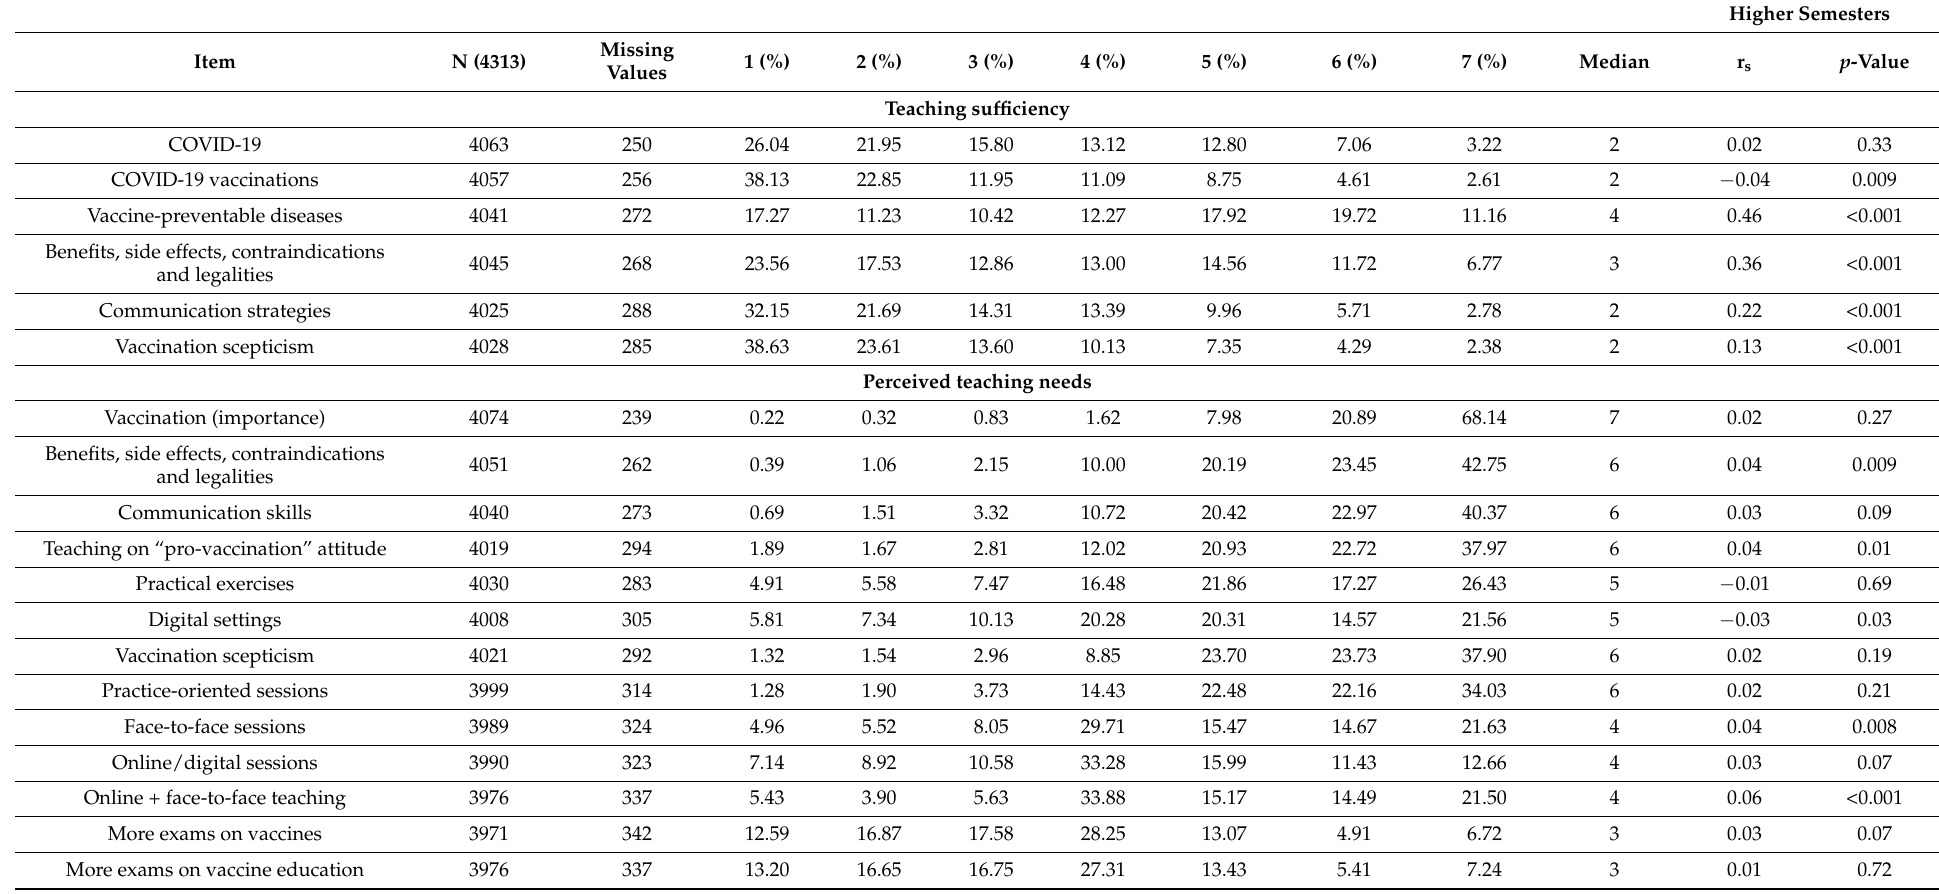
Table 1. Complete case analysis of questions related to teaching status on vaccinations and informing others, shown for all students who answered the individual items. Relative percentages are shown of participants choosing individual values on a 7-point Likert-like scale: only the endpoints 1 (fully disagree) and 7 (fully agree) were labelled in the